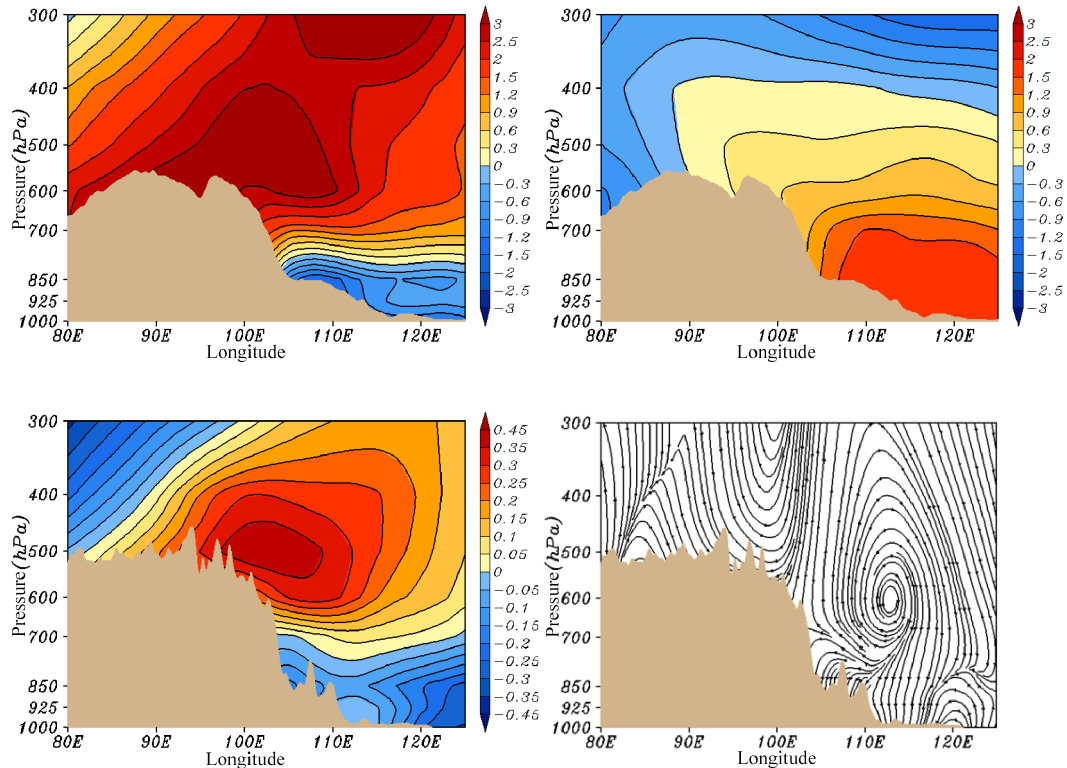
Figure 6. Vertical sections of the anomalous air temperature ( ◦ C) averaged along 27–41 ◦ N in five winters with most positive (upper left panel) and most negative Q 1 anomalies (upper right panel) on the TP from 1980 to 2012, and vertical sections of the correlations of the number of haze days with air temperature (lower left panel) and vertical circulations (lower right panel) in winter from 1980 to 2012.